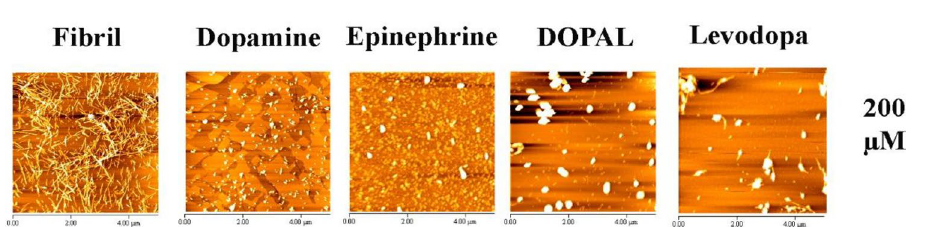
Figure 4. AFM images of protein samples incubated alone or in the presence of catechols (200 µM), for 60